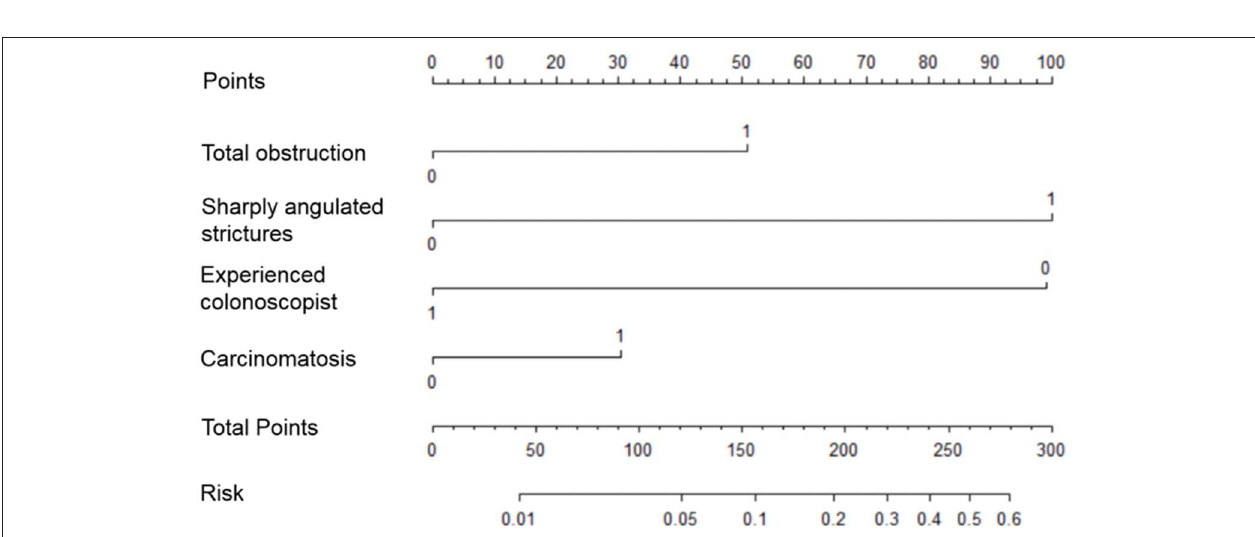
FIGURE 2 | Rates of guidewire insertion, technical, and clinical success before and after SAGWI in 509 patients with malignant colorectal obstruction. SAGWI, sphincterotome-assisted guidewire insertion; ITT, intention-to-treat analysis; PP, per-protocol analysis. ** p < 0.001.